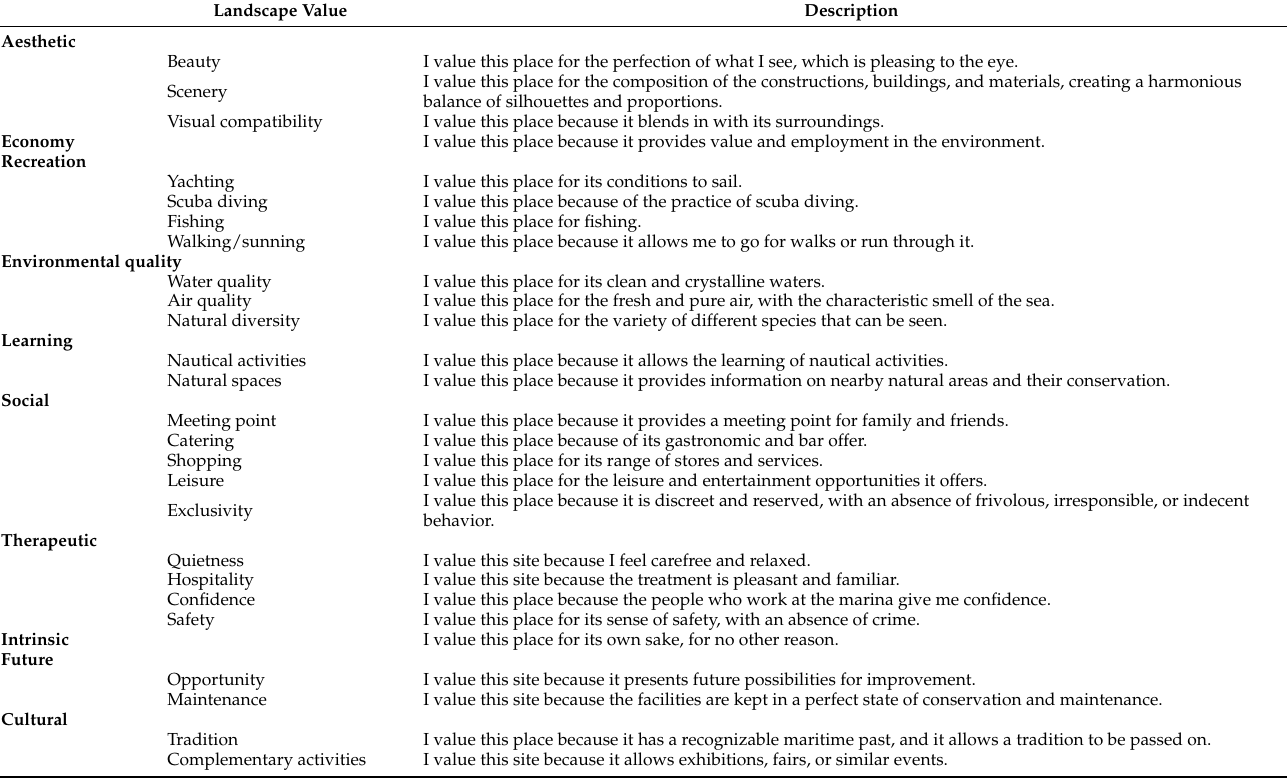
Table A2. Marina landscape values’ definitions.